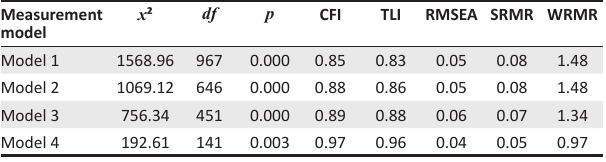
TABLE 3: Goodness-of-fit indices of the measurement models.